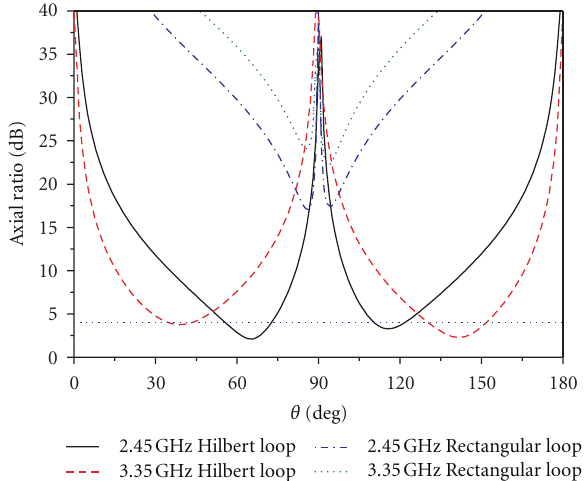
Figure 14: Axial ratio of the proposed flexible Hilbert-curve loop antenna and rectangular loop antenna at φ = 0 ◦